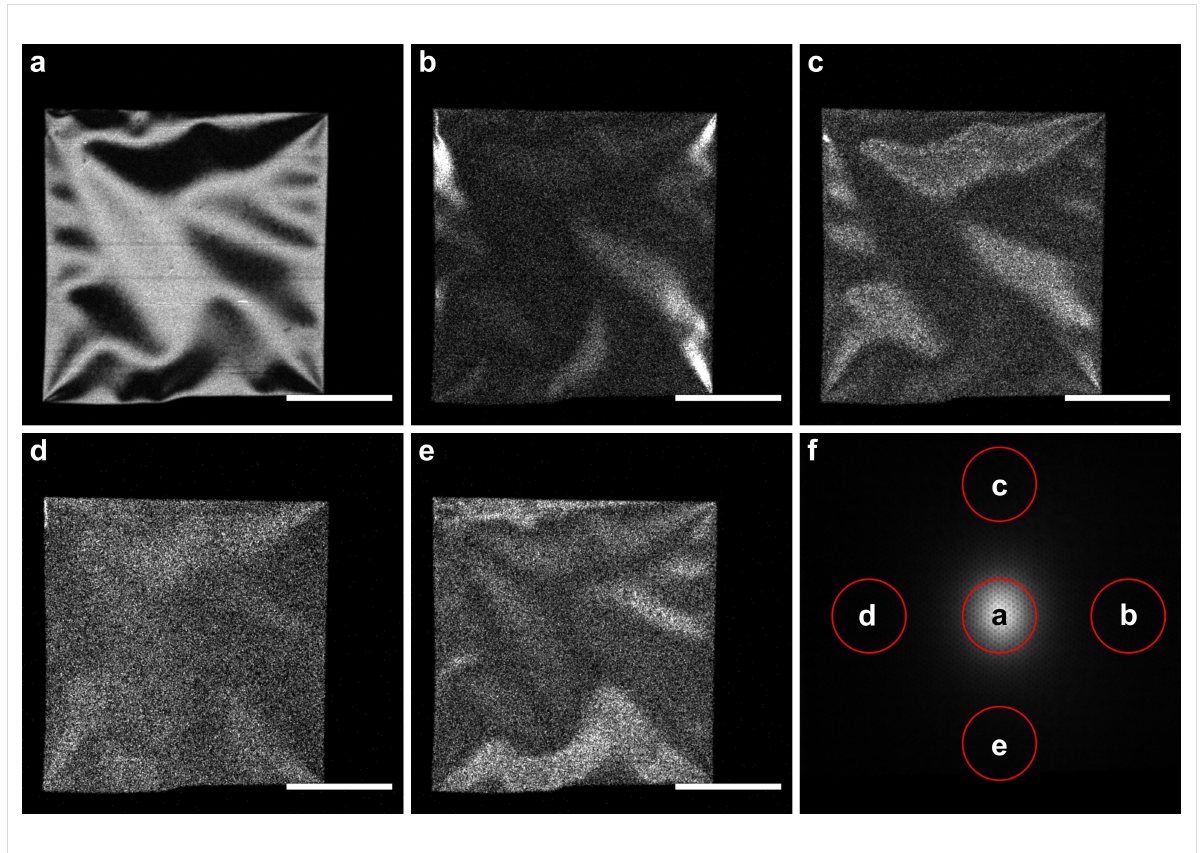
Figure 6: STIM images of a single-crystalline silicon ⟨ 100 ⟩ membrane in (a) bright-field with θ ≤ 1.09°, and in dark-field centered at the polar scat- tering angle θ = 3.8°, with azimuthal angle center ϕ = 0° in (b), ϕ = 90° in (c), ϕ = 180° in (d), and ϕ = 270° in (e). (f) Overall distribution of all counts on the detector. The areas on the detector for the corresponding STIM image are marked in red. The scale bars are 50 μ m for (a–e). In (f), the dis- tance from the center of the image to edge corresponds to a 5.58° deflection in the polar